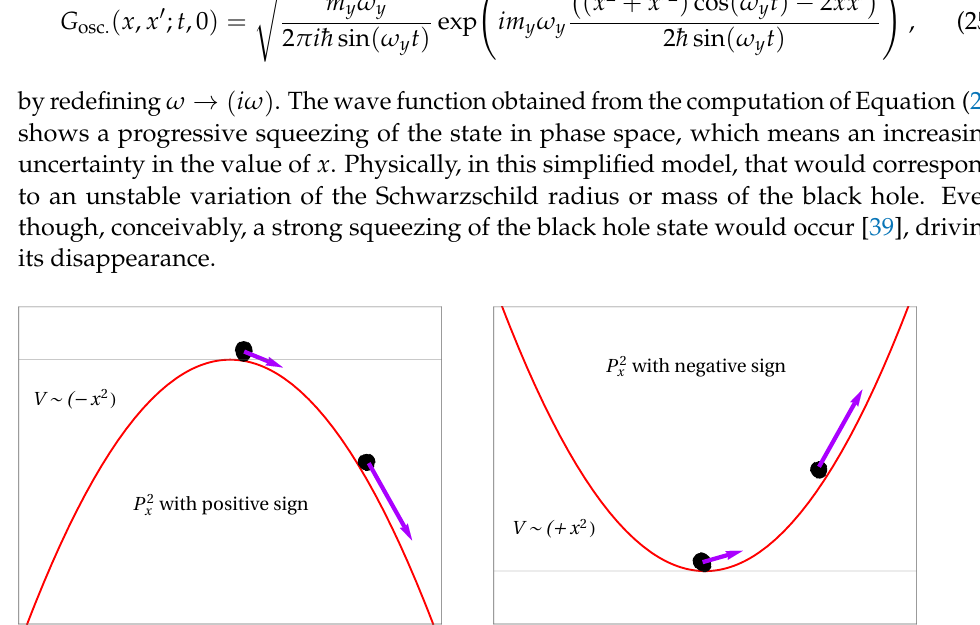
Figure 1. The behaviour of a particle in an inverted oscillator potential, with a positive kinetic term, is equivalent to the behaviour of a particle, with a negative kinetic term, in a regular harmonic oscillator